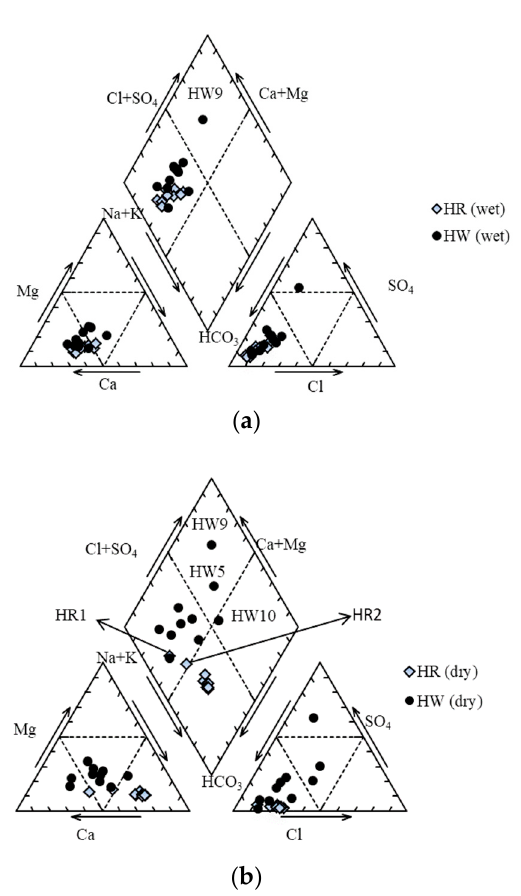
Figure 3. Piper diagram of major ions of groundwater and river water in ( a ) wet season ( b ) dry season. HR = Hanumante river water, HW = Hanumante groundwater.